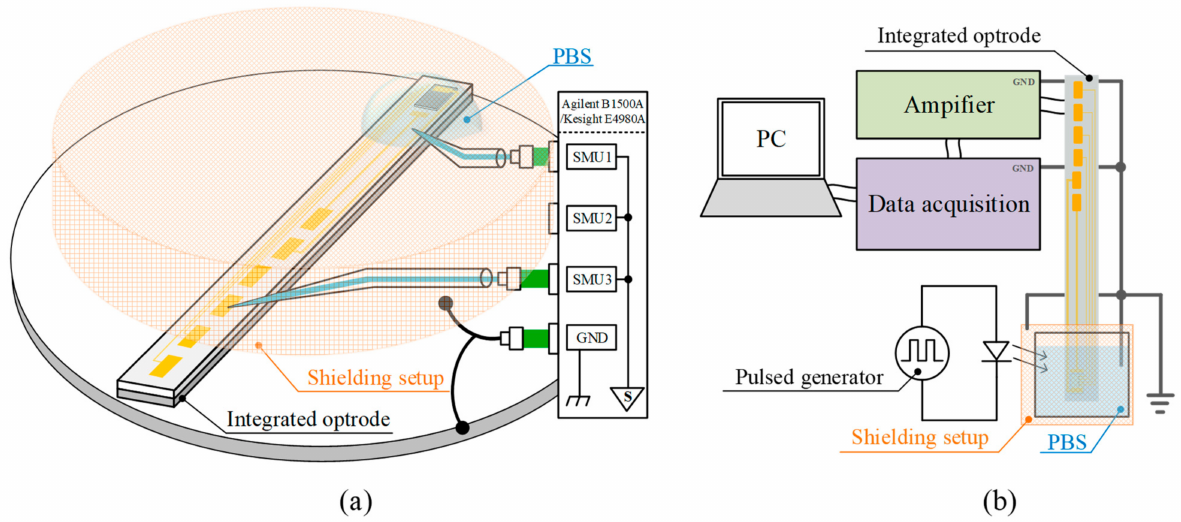
Figure 3. ( a ) The proposed testing system for electrical characterizations with a semiconductor device analyzer or LCR meter in PBS with shielding. ( b ) The testing system for optical artifacts with amplifier and data acquisition card in PBS with shielding, while the optical artifacts are generated by a light-emitting diode driven by a pulse